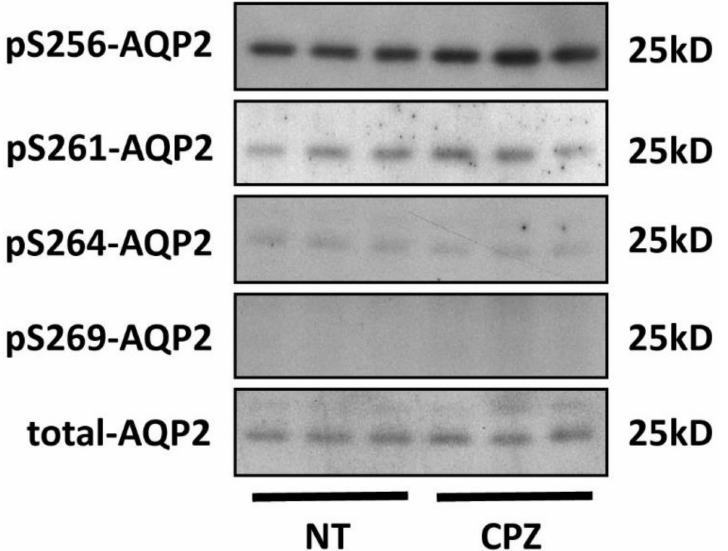
Figure 2. CPZ does not a ff ect AQP2 phosphorylation in polarized MDCK cells: AQP2-MDCK cells were incubated with CPZ (100 µ M for 15 min) or without CPZ (NT), then were subjected to Western blotting. After CPZ treatment, AQP2 phosphorylation status at Ser-256, Ser-261, Ser-264, and S269 was not